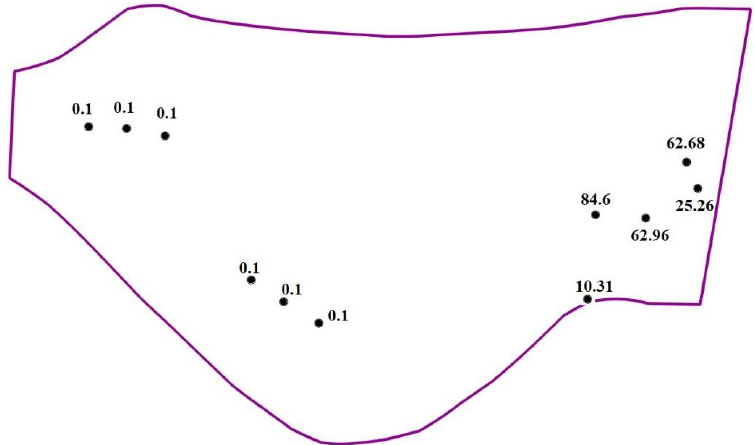
Figure 12. Bed sample locations with d 50 in mm . Table 4. Size classes in the JiJi Reservoir.